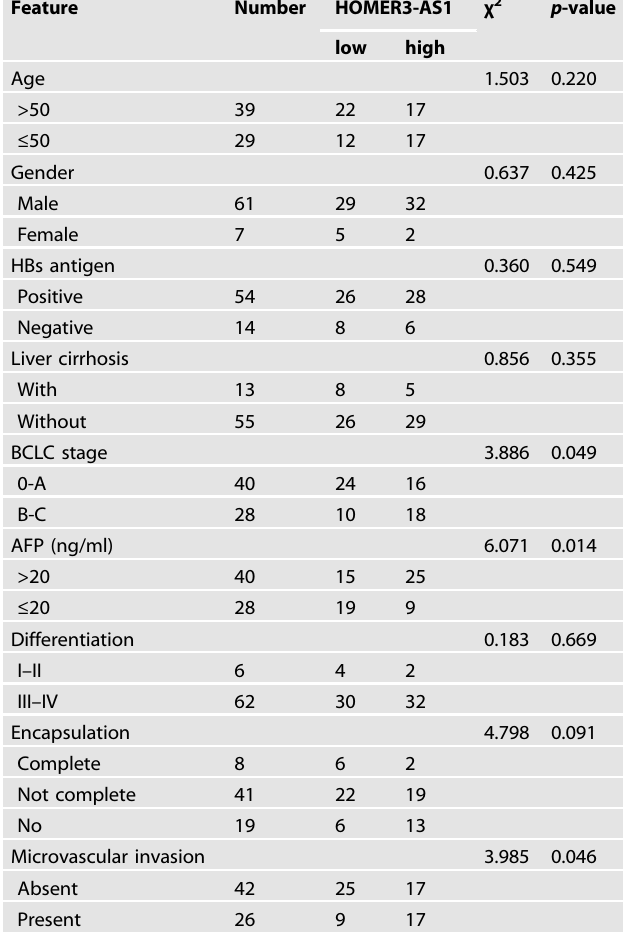
Table 1. Correlation between HOMER3-AS1 expression levels and clinicopathological characteristics in